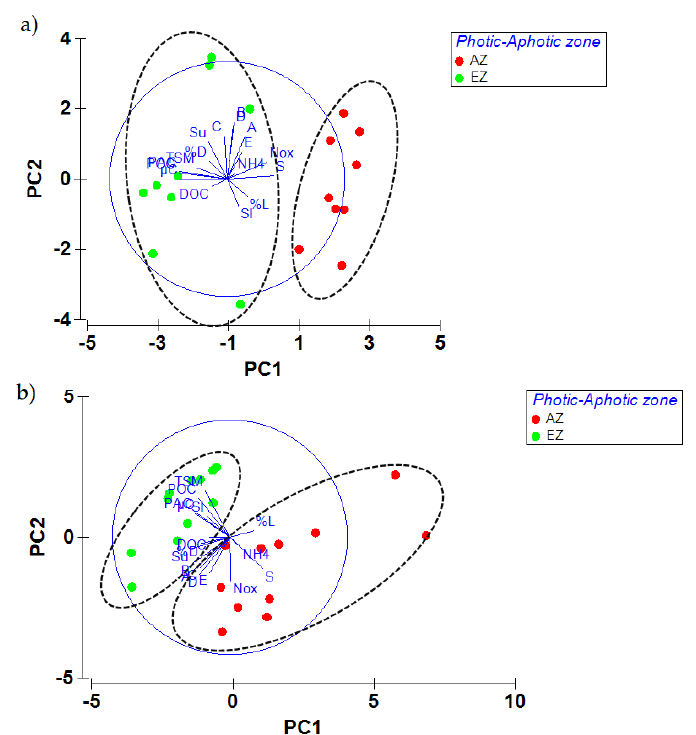
Figure 10. Principal Component Analysis (PCA) of key environmental and biological variables selected on the basis of the Spearman rank correlation matrix, in the two areas ( a ) A area, ( b ) C area, for the euphotic (EZ, green points) and aphotic (AZ, red points) zones. For details on correlation factors, see the supplementary material. For a clearer reading of the diagrams, the following symbols have been associated with some variable: Nox = NO 2 +NO 3 ; % L = % Live; % D = % Dead; A = AWCD; B = Richness; C = Complex carbon source; D = Carboydrates; E = Amines; Sl = S 275-295 ; Su = SUVA 254.